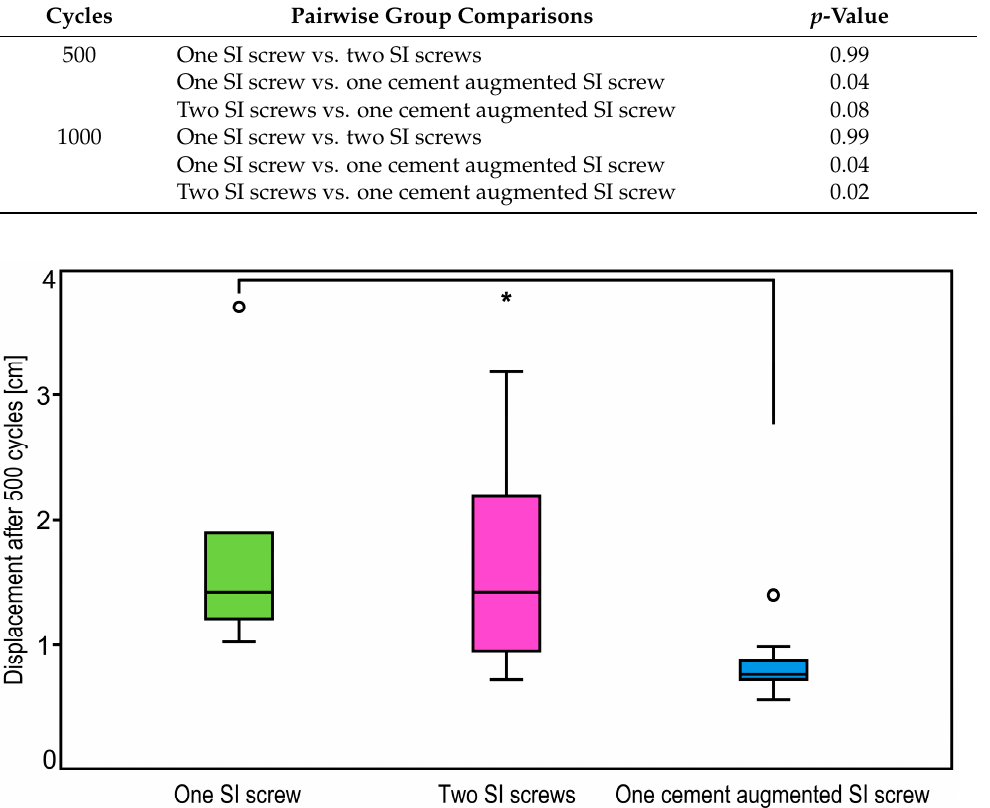
Figure 5. Boxplots showing fracture displacement in the groups after 500 cycles with a star indicating significant difference between the treatments using one cement augmented SI screw or one SI screw.